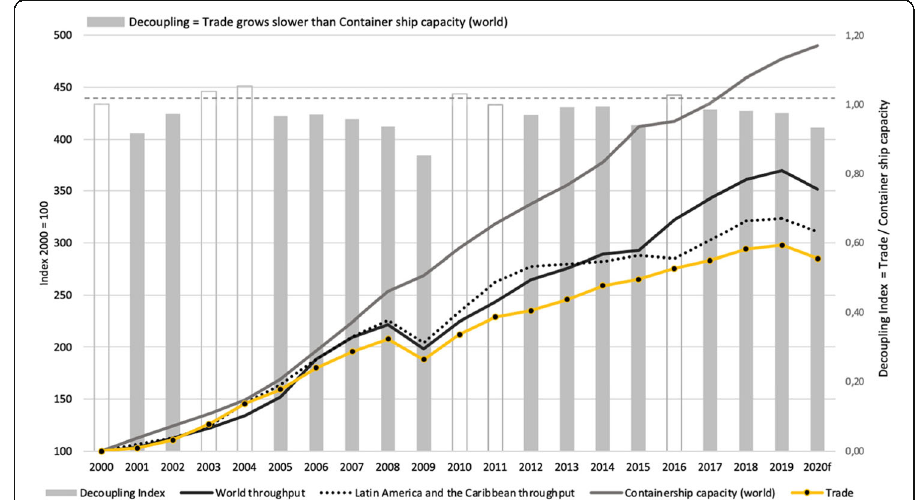
Fig. 2 Decoupling: trade, throughput, and nominal capacity of the fleet. Source: updated from Barleta and Sanchez (2018). Note: 2020f according to Clarkson March